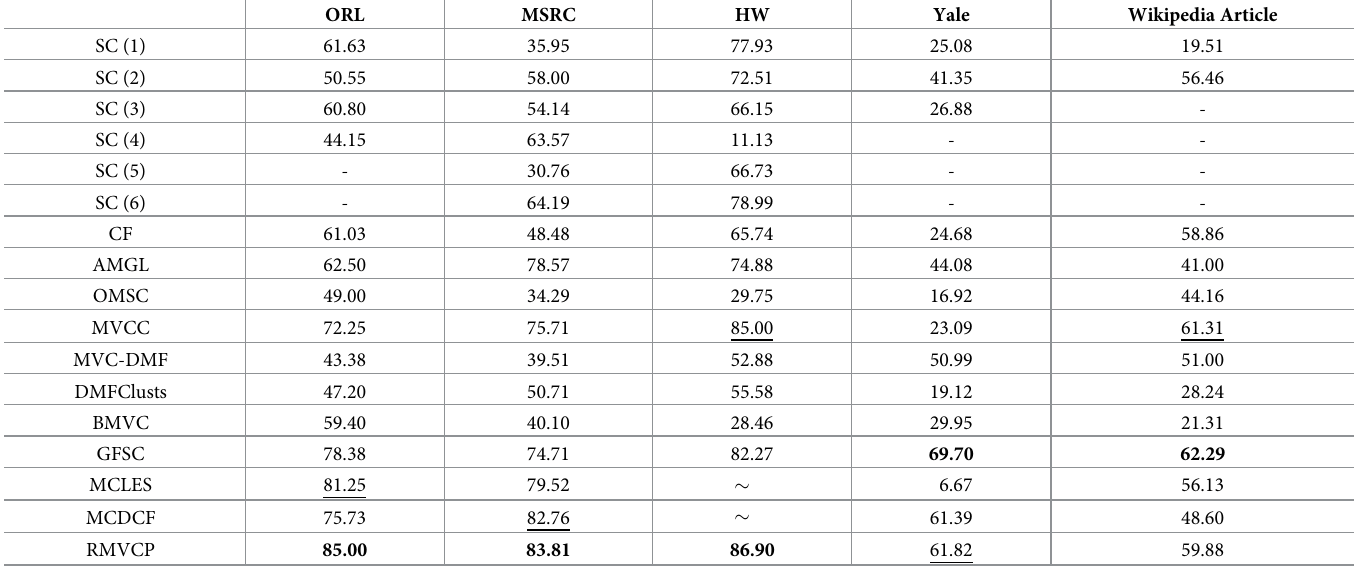
Table 4. Comparison of algorithms on five datasets for Purity.